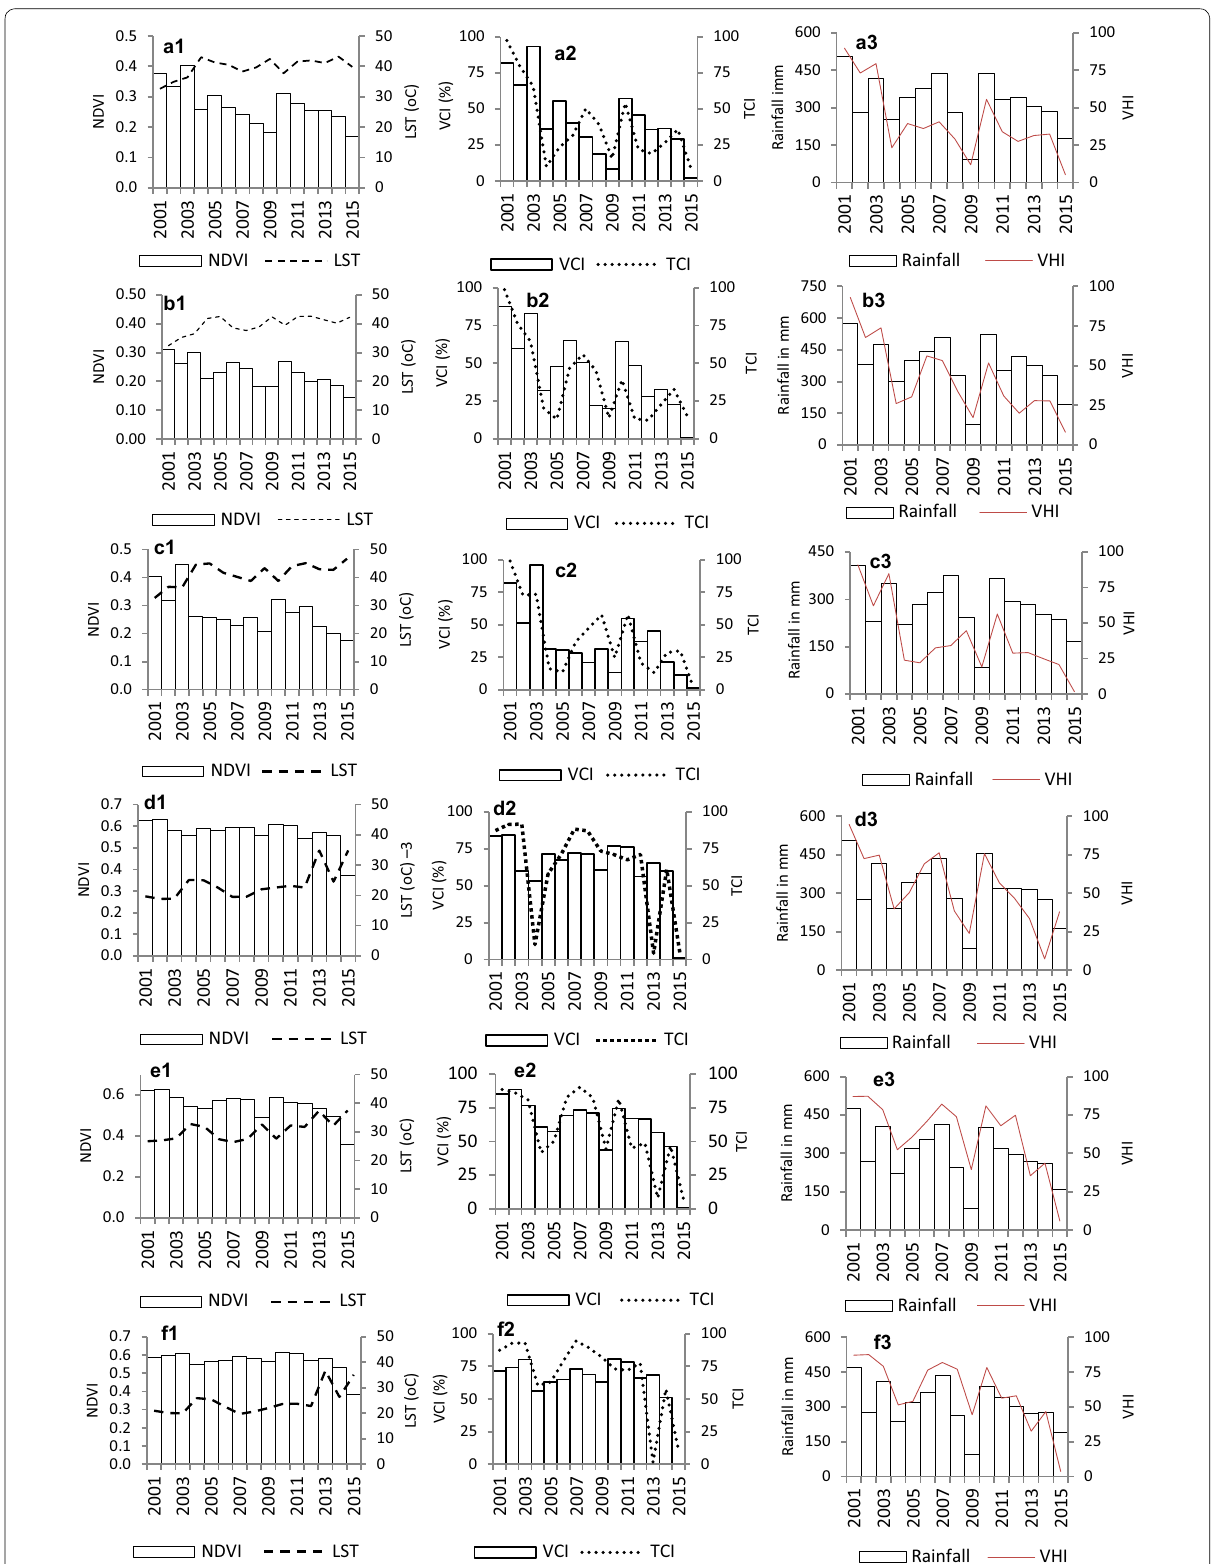
Fig. 3 Multi-temporal trend of LST-NDVI, VCI-TCI, and VHI—rainfall 2001–2015. Lowlands area: a1 – a3 Yalo, b1 – b3 Megale, c1 – c3 Gulina, Midlands area: d1 – d3 Raya Azebo, e1 – e3 Alamata, f1 – f3